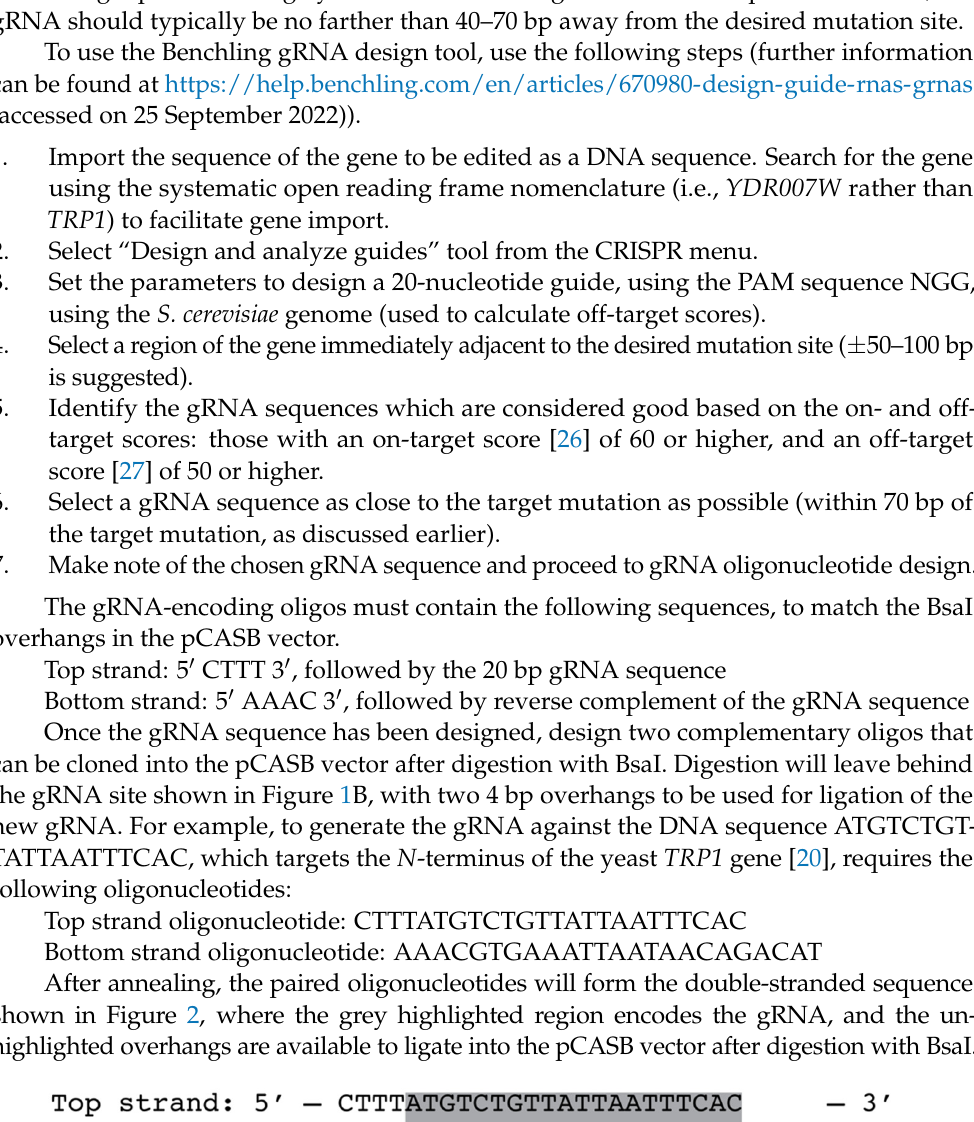
Figure 2. Example of the double-stranded DNA sequence and 4 bp overhangs resulting from annealing of gRNA oligonucleotides, before ligation into the pCASB vector. The sequence highlighted in grey encodes the gRNA 5’- ATGTCTGTTATTAATTTCAC -3’, targeting the N-terminus of the yeast TRP1